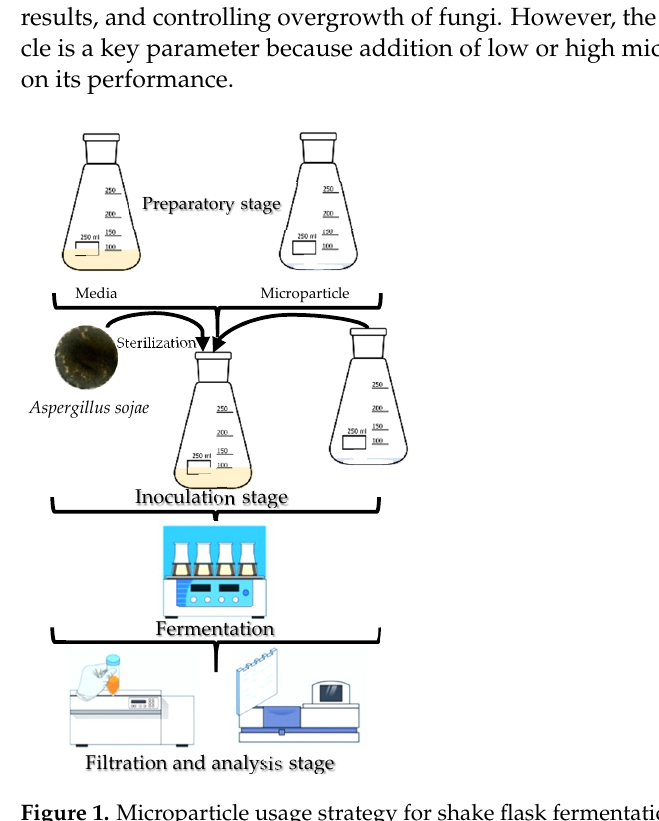
Table 2. Microparticles and their applications for biological processes. Microparticle